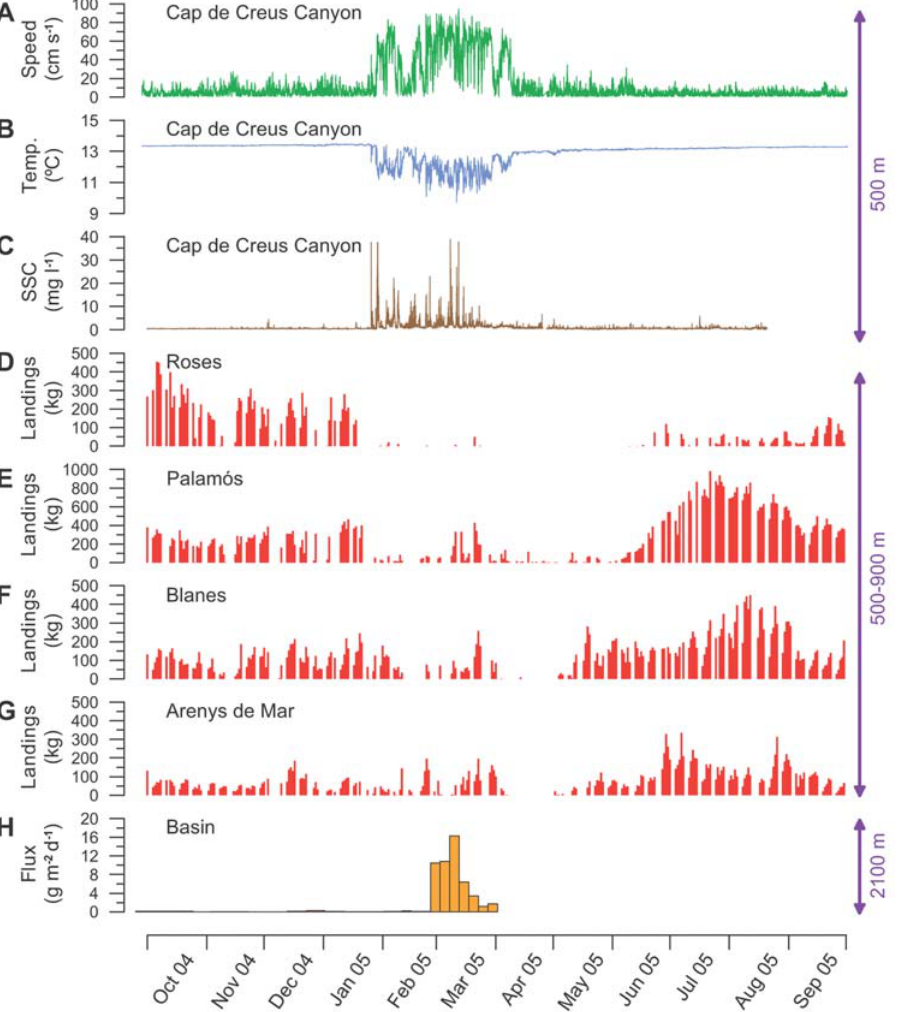
Figure 2. Mooring time series and daily catches. (A–C) Current speed (A), temperature (B) and suspended sediment concentration (SSC) (C), recorded in the Cap de Creus Canyon at 500 m depth (placed at 5 m above bottom), before, during and after the cascading event of winter 2005. (D– G) Daily landings of Aristeus antennatus at the studied harbors are plotted as red bar charts, ordered from northeast (Roses) to southwest (Arenys de Mar). (H) Downward mass fluxes recorded at 2100 m depth by the sediment trap moored in the basin at 2350 m depth (i.e. 250 m above bottom) are illustrated by the orange bar chart. See locations in Figure 1.